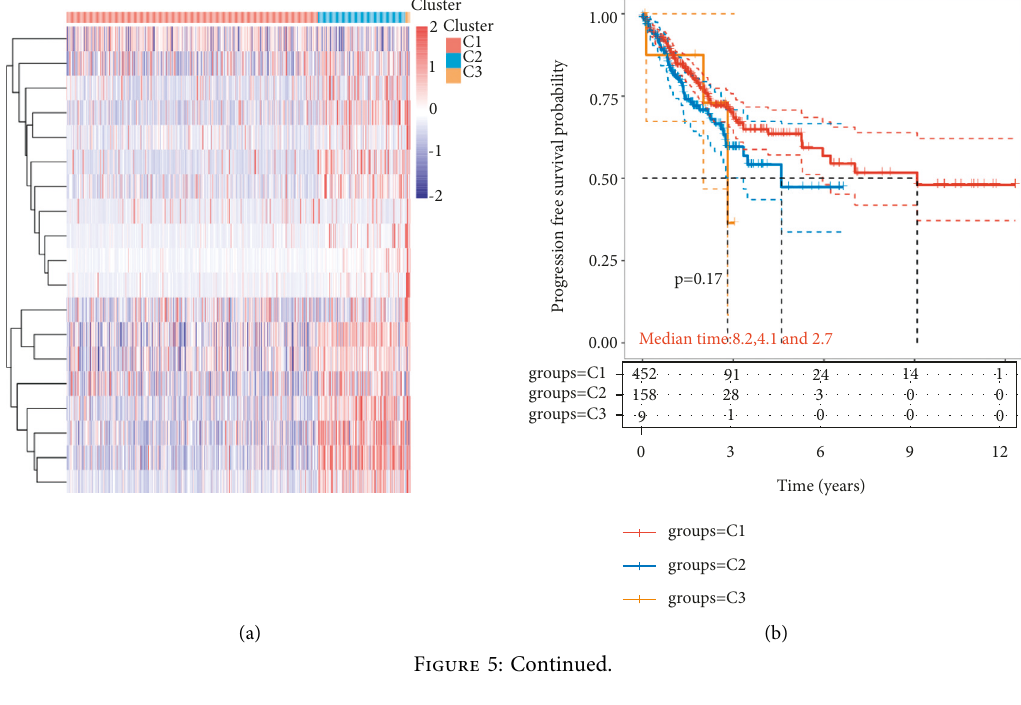
Figure 4: Consensus clustering analysis for CRC based on the expression of significantly somatic mutated genes. (a) The cumulative distribution function analysis of CRC subtypes. (b) Relative change in the area under the CDF curve (CDF delta area) presented. At k analysis had the best delta area scores. (c) Three subtypes of CRC identified in CRC samples. (d) The PCA analysis of three subtypes of CRC